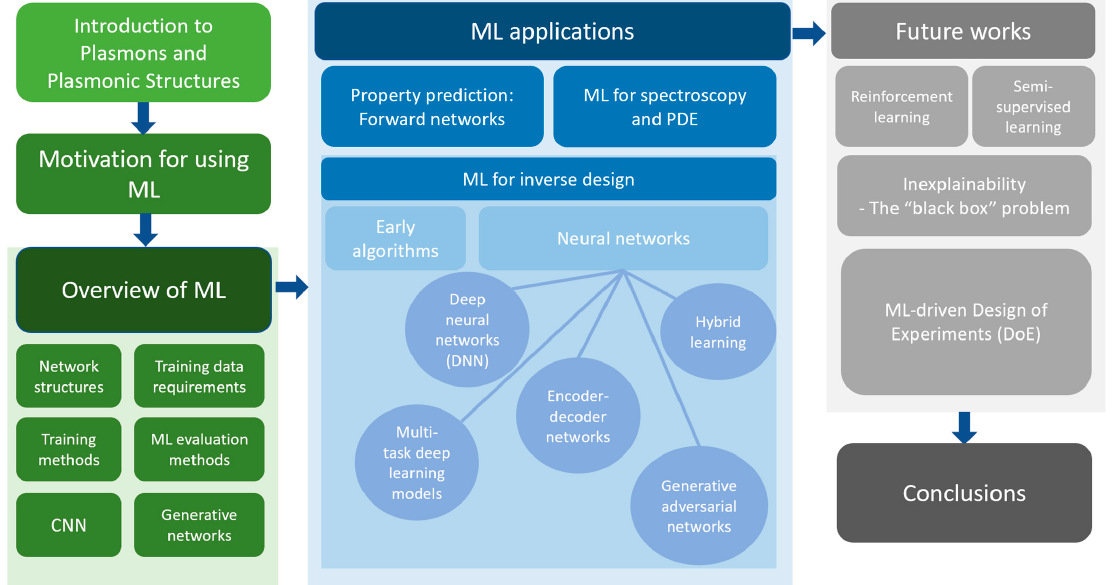
Figure 4. Review methodology of this paper. The green panels are background introductions to plasmonic structures, ML, and the motivation to apply ML as a practical tool to characterize and design plasmonic structures. The blue panel, as the main body of the paper, corresponds to the current applications of ML methods in the plasmonics research. The inverse design methods are analyzed chronologically from early genetic algorithms to contemporary neural networks. The gray panel communicates the future perspectives of research that we encourage to connect more gaps between plasmonic and ML research.